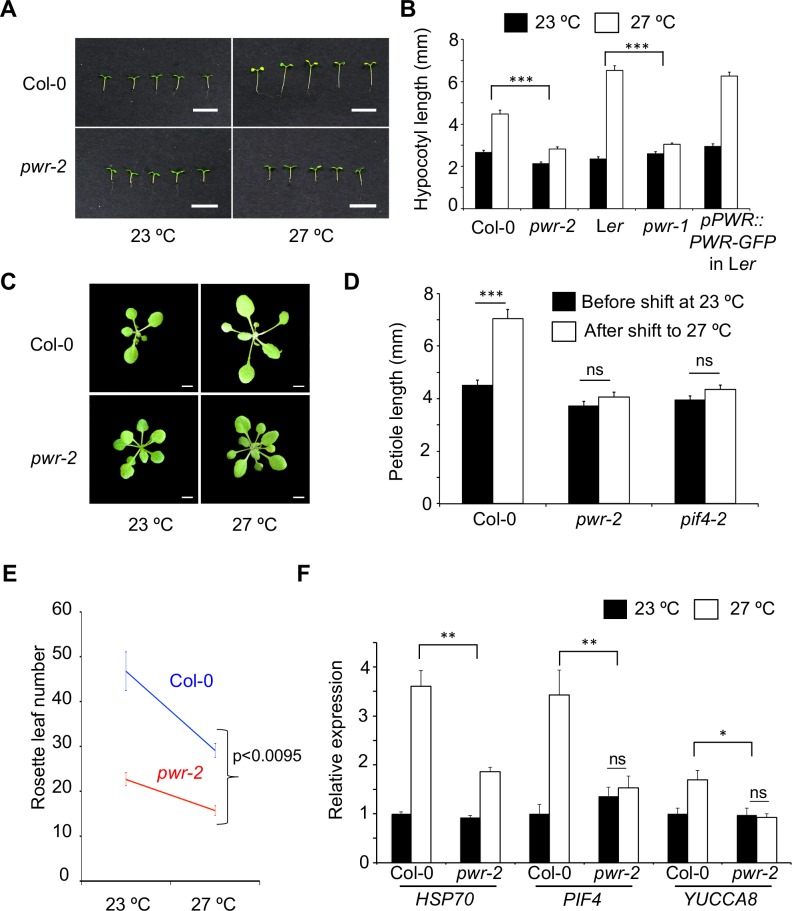
Mutations in PWR attenuate thermal responses.A) Hypocotyl lengths of pwr-2 compared to Col-0 at two different temperatures in short days. B) Hypocotyl length of various genotypes at different temperatures. The p-value for the GxE interactions is shown above the bar graphs. pwr-2 is in the Col-0 background. pwr-1 and pPWR::PWR-GFP are in the Ler background. N = 15 for all samples. C) Petiole elongation of Col-0 and pwr-2 two days after shift to 27°C. The same plants are shown before and after the shift. D) Quantification of petiole elongation. N = 23–45. E) Flowering time measured as rosette leaf number in Col-0 and pwr-2 at 23°C and 27°C with p-value for GxE interaction. F) Relative expression levels of HSP70, PIF4 and YUCCA8 in Col-0 and pwr-2, in 2-week old seedlings at 23°C and 27°C. Data are averages from three independent biological replicates, with each representing approximately 25–30 seedlings. p-value for the GxE interaction is shown. p-values: ***<0.0001, **<0.001, *<0.05, ns = not significant. Error bars represent standard error. Scale bars: A – 10 mm; C – 5mm.